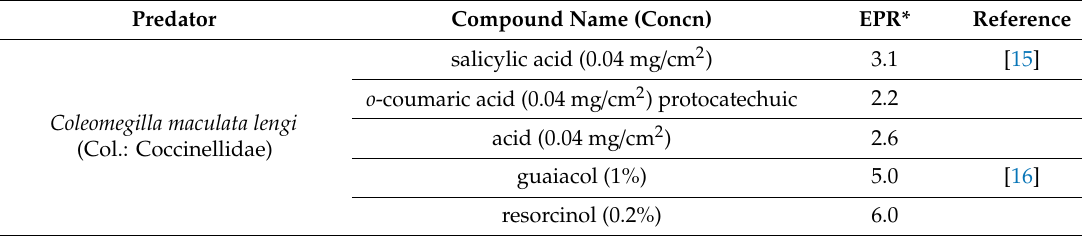
Table 1. Volatile and non-volatile organic compounds (VOCs) stimulating oviposition behavior in coccinellids, syrphids, and chrysopids, with minimal e ff ective conc., and egg production ratio